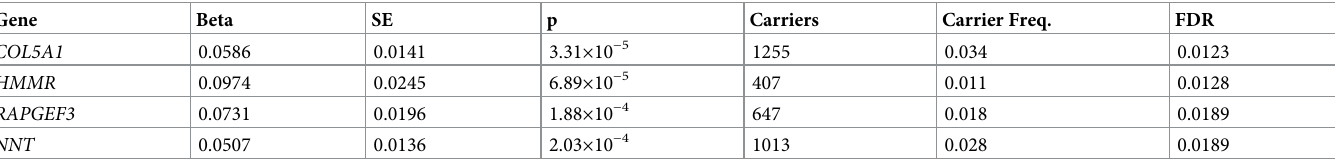
Table 4. Novel gene burden associated with degree hearing loss (FDR < 0.05) in PMBB. Gene Beta SE p Carriers Carrier